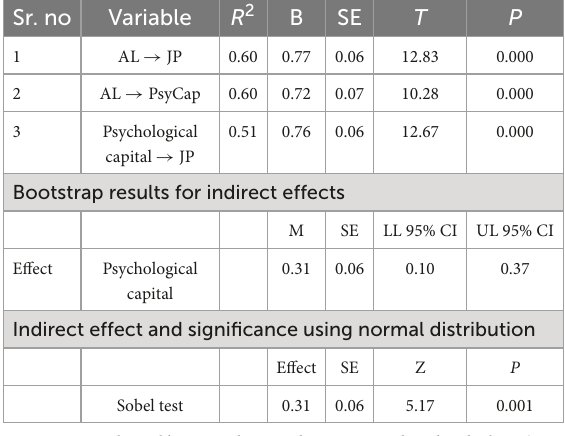
TABLE 4 Mediating role of PsyCap.